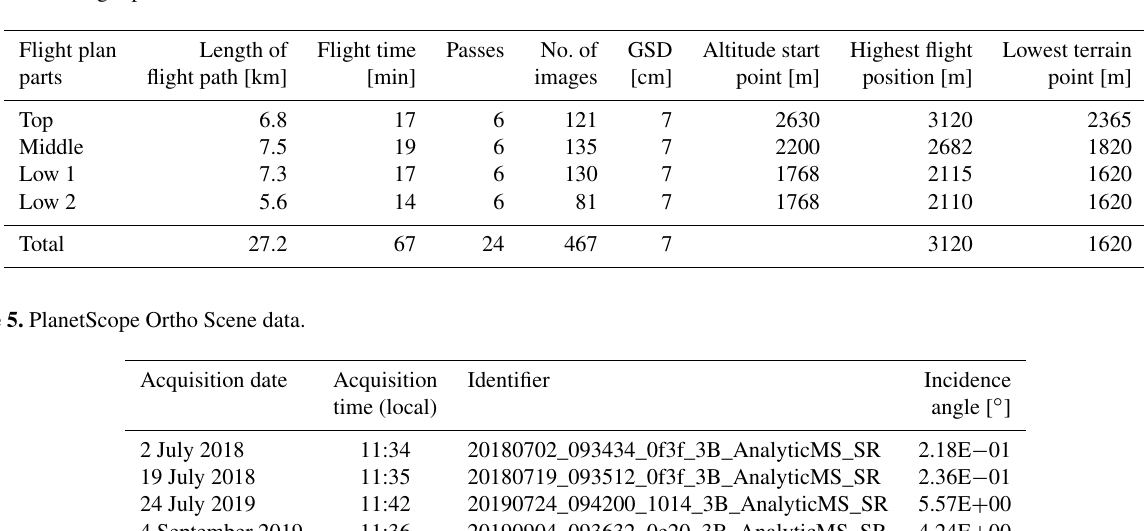
Table 4. UAS flight plans.